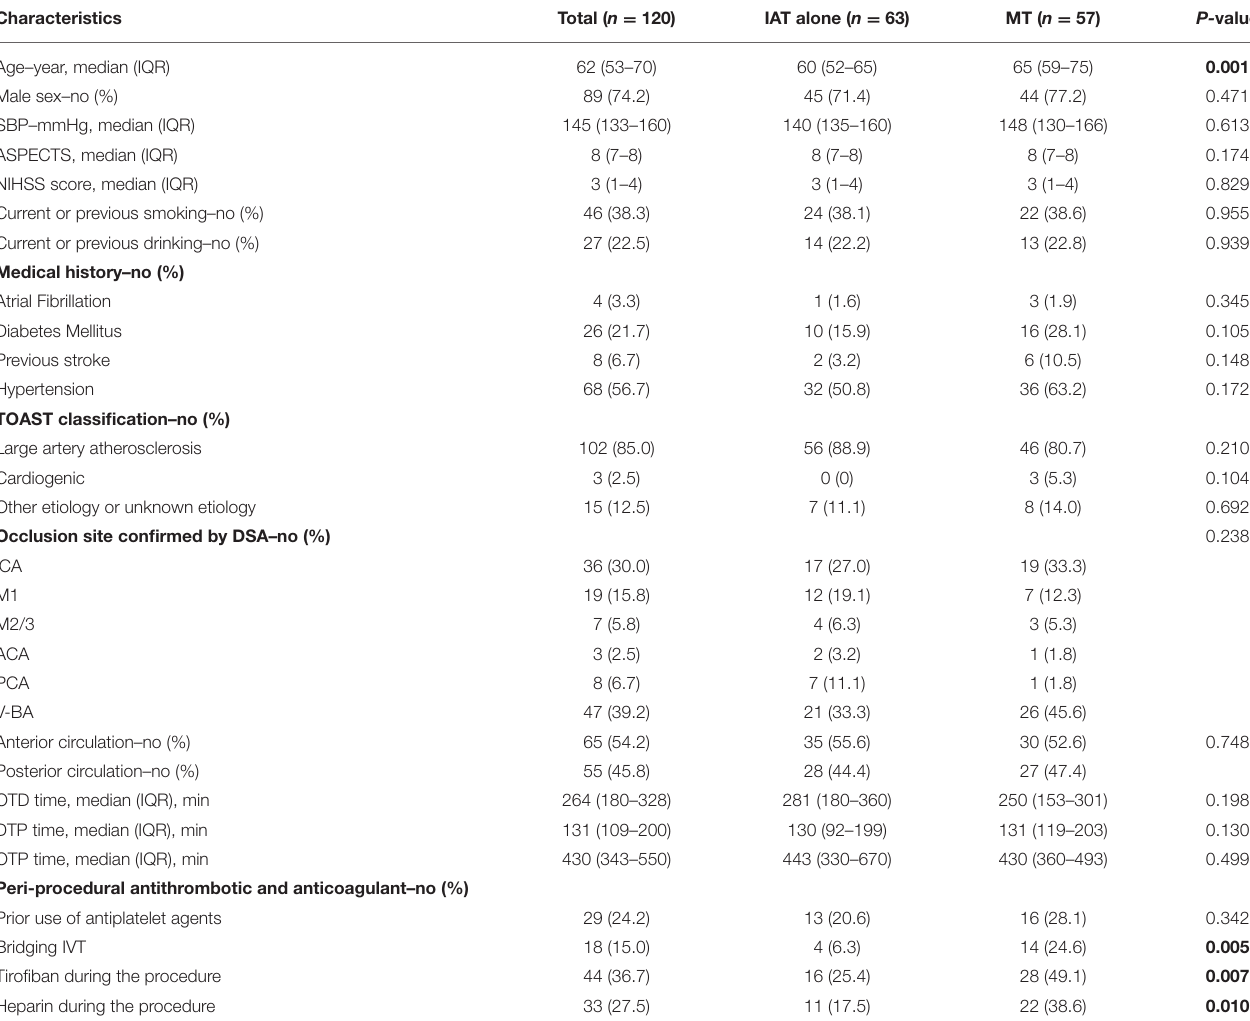
TABLE 1 | Baseline characteristics of IAT alone and MT group in LVO patients with minor stroke.